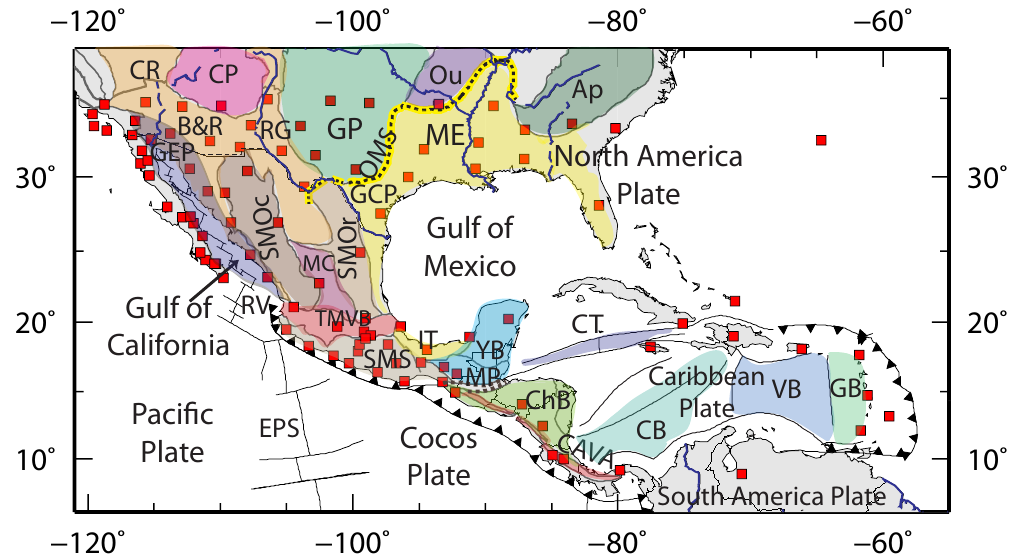
Figure 1. Simplified tectonic map of the study area: physiographic provinces shown as gray lines (Sedlock, 1993; M. Moschetti, personal communication, 2011; Marshall, 2007); stations as red squares; and plate boundaries as black lines (Bird, 2003). Ap denotes Appalachian Plateau Province; B&R Basin and Range; CAVA Central America Volcanic Arc; CB Colombian Basin; ChB Chortis Block; CP Colorado Plateau; CR Colorado River; CT Cayman Trough; EPS East Pacific Rise; GB Grenada Basin; GCP Gulf Coastal Plain; GEP Gulf Extensional Province; GP Great Plains; IT Isthmus of Tehuantepec; ME Mississippi Embayment; MC Mesa Central; MP Motagua–Polochic fault system; Ou Ouachita Province; RG Rio Grande; RV Rivera Plate; SMOc Sierra Madre Occidental; SMOr Sierra Madre Oriental; SMS Sierra Madre del Sur; TMVB Trans-Mexican Volcanic Belt; VB Venezuela Basin; and YB Yucatan Block. Blue lines indicate main rivers. Highlighted yellow dashed black line indicates the Ouachita–Marathon–Sonora orogenic belt (OMS). Its extension into Mexico is taken from Handschy et al. (1987). The GEP location is taken from Zhang et al.